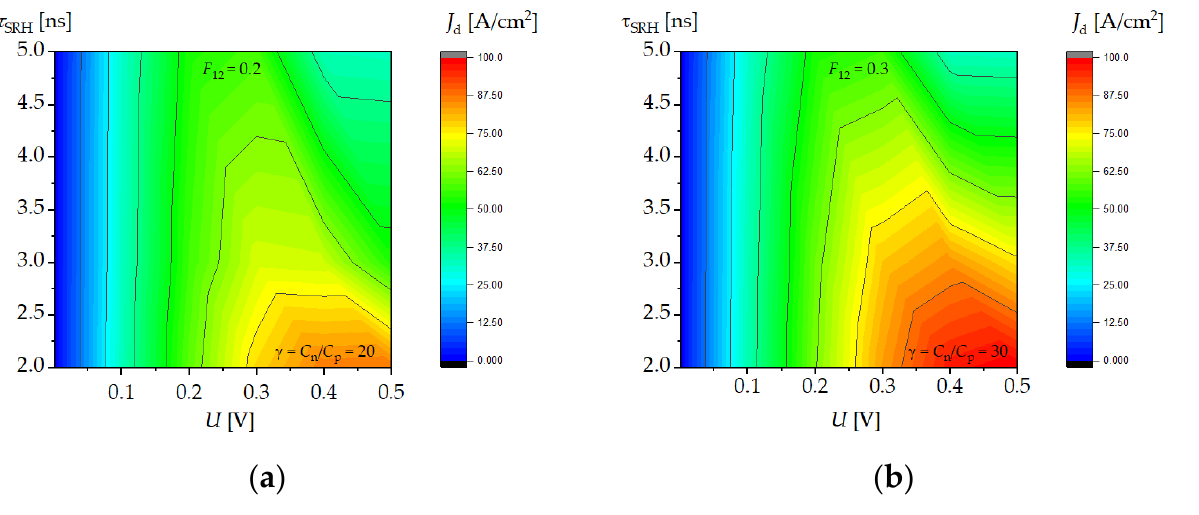
Figure 8. Distributions of the dark current density in the reverse direction as a function of voltage and SRH lifetime in the LWIR2 structure for ( a ) γ = 20, F 12 = 0.2; and ( b ) γ = 30, F 12 = 0.3. The dark I – V characteristics for different values of the SRH lifetime are shown in Figure 9. These characteristics were based on the dark current density distribution taken from Figure 8b. We can see how small changes in the SRH lifetime caused a significant change in the I – V characteristics. With longer SRH lifetime, Auger suppression was weaker, while at τ SRH_n = 2–3 ns, Auger suppression was strong and caused a rapid change in the dark current. This change resulted from the strong suppression of Auger generation shown in Figure 10. When the voltage changed from − 0.34 V to − 0.37 V, the Auger generation rate decreased by five times, and the SRH recombination rate increased and maintained a constant value for higher voltages; consequently, the dark current saturated (Figure 9).